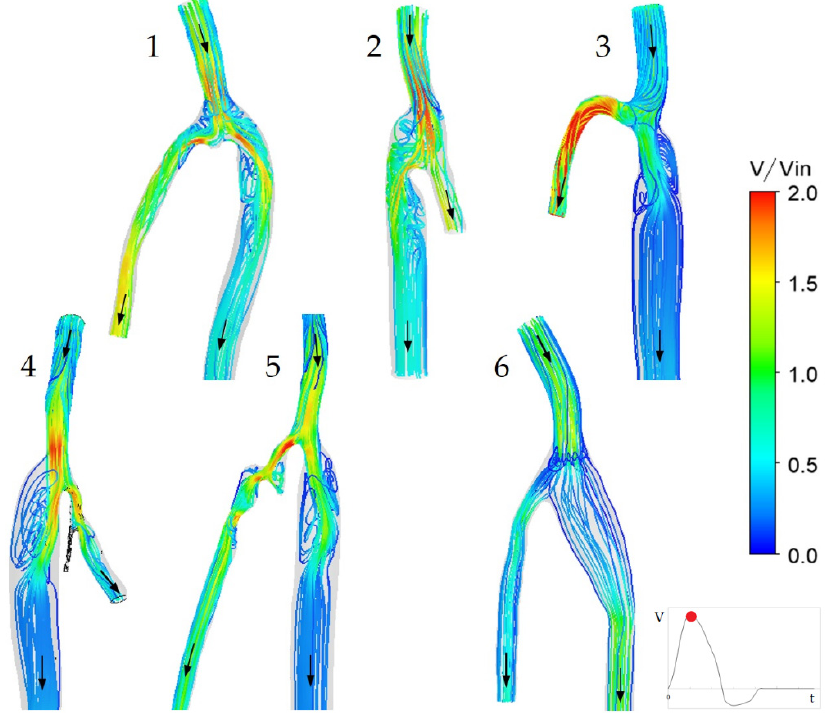
Figure 7. 3D streamlines at the instance of maximum flow. Arrows indicate the blood flow direc-